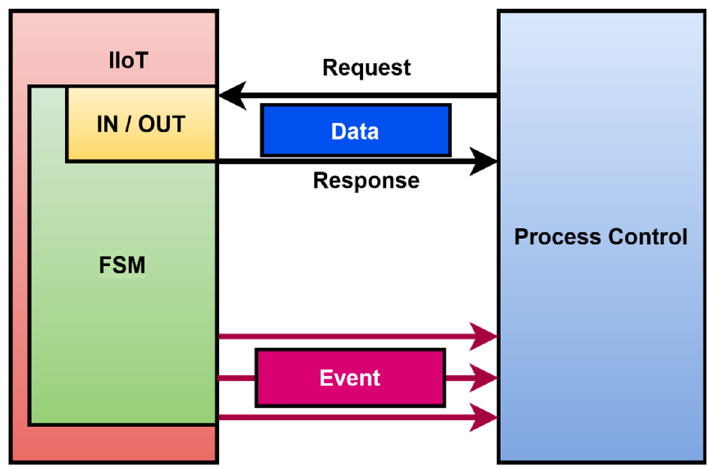
Figure 3. Model industry IoT device and its integration.